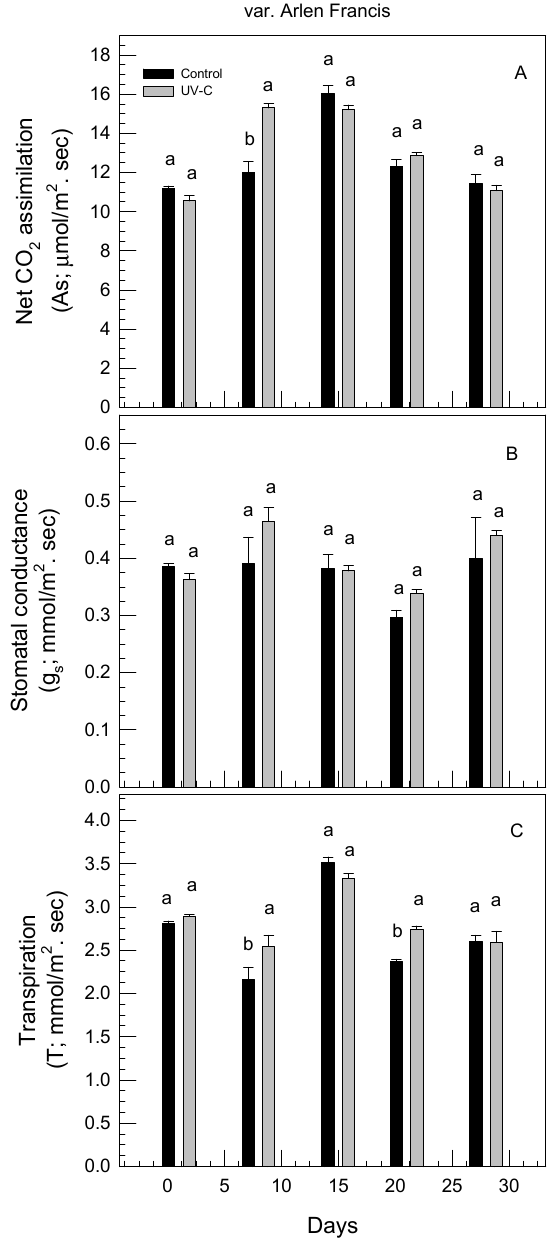
Figure 3. Net CO 2 assimilation ( A ), stomatal conductance ( B ) and transpiration ( C ) of var. “Arlen Francis” rose plants irradiated with 2.5 kJ/m 2 of left untreated (controls) over a 3-week period during GST. Data are means ±S.E. Different letters indicate significant differences between treatments at p = 0.05.